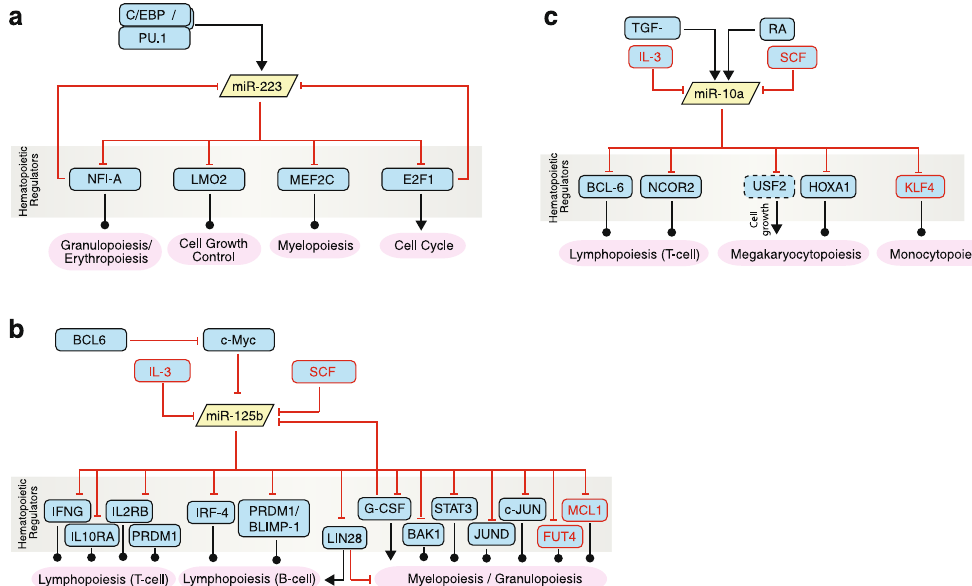
Figure 6. The miR-223, miR-125b and mir-10a regulatory circuits in human hematopoiesis. miR-223 regulates myeloid differentiation via the transcription factors LMO, MEF2C, NFI-A, and E2F1. The latter two are themselves negative regulators of miR-223 expression and thus fine-tune miR-223 in a negative feedback loop ( a ). miR-125b is involved in the regulation of T-cell and B-cell differentiation as well as granulopoiesis by repressing the expression of a number of different transcription factors. We found that miR-125b expression is inhibited by IL-3 and SCF, among other regulators ( b ). miR-10a is another regulator of myeloid and lymphoid differentiation targeting BCL-6 and NCOR2 in lymphopoiesis, USF2 and HOXA1 in megakaryocytopoiesis, and KLF4 in